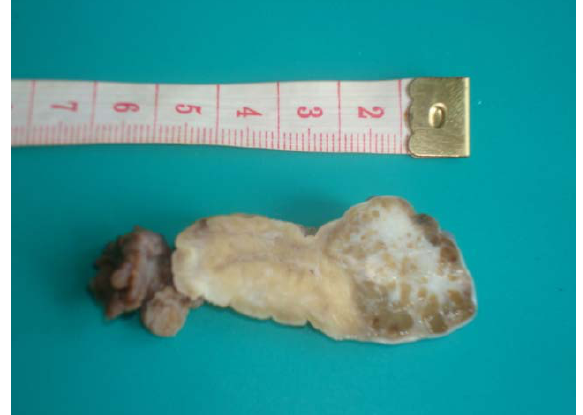
Figure 2. Cut surface of right ovary shows the greyish white, well demarcated Sertoli-Leydig cell tumour.